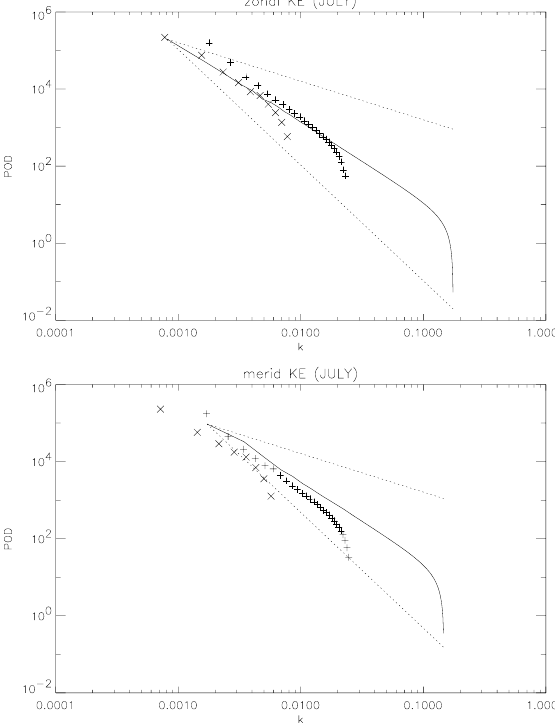
Fig. 2. As Fig. 1, but for summer